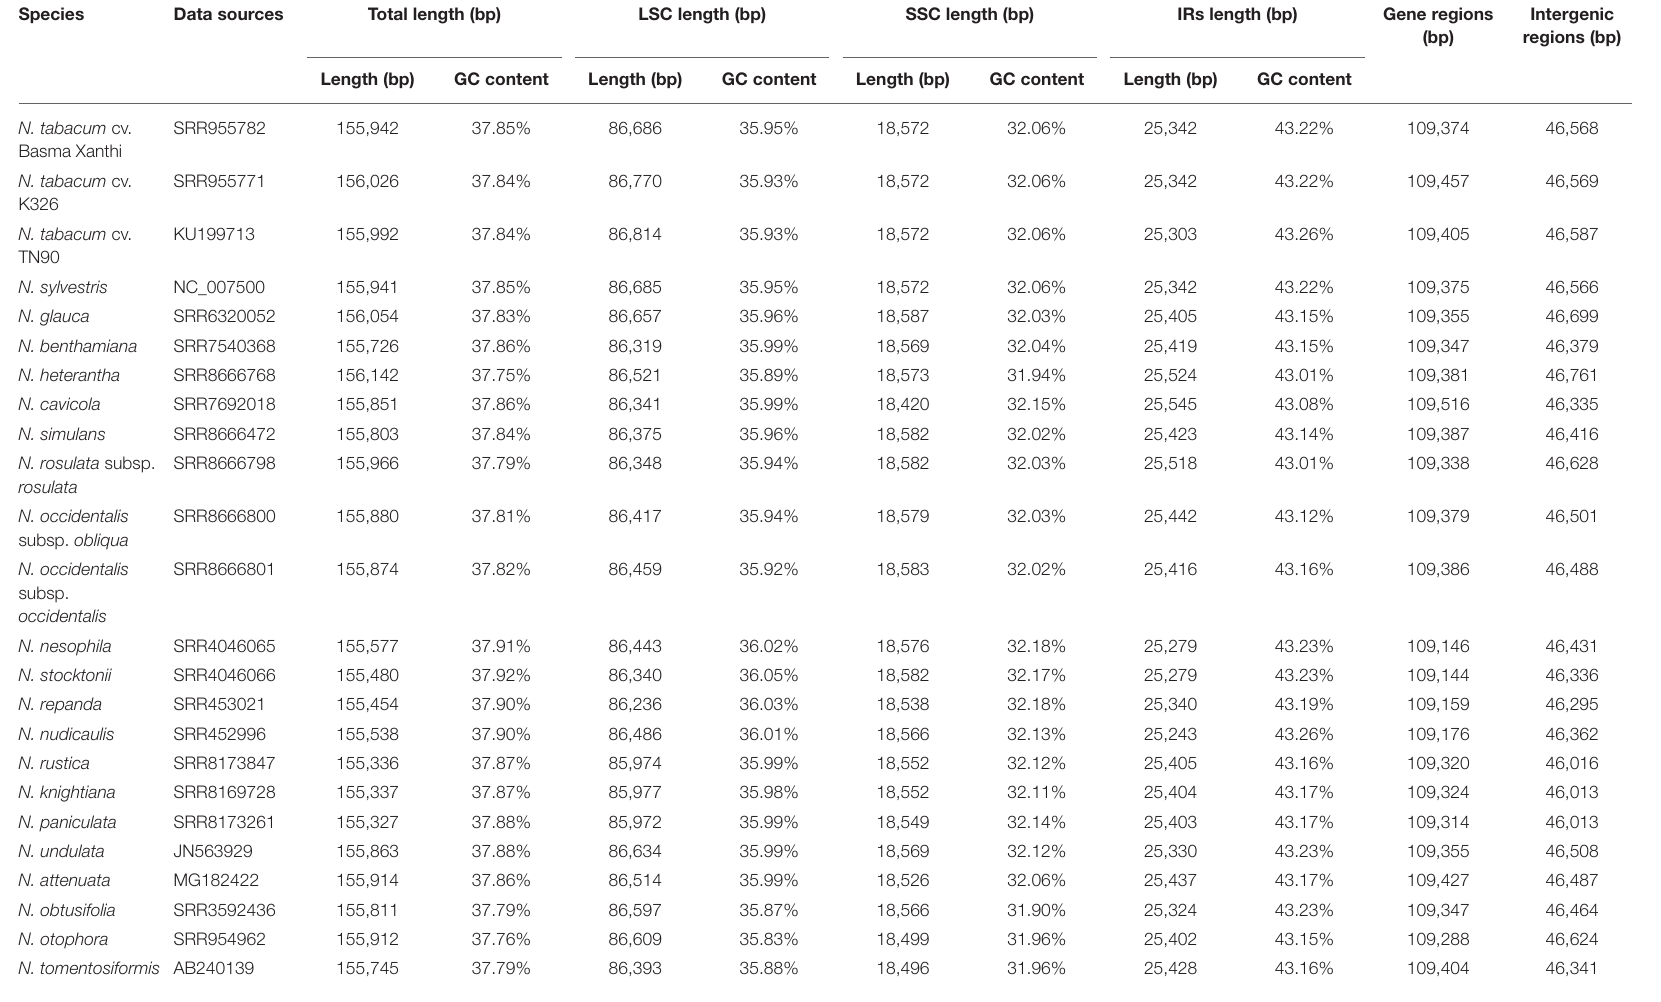
TABLE 1 | Sample information and summary of 24 chloroplast genome characteristics of Nicotiana species.